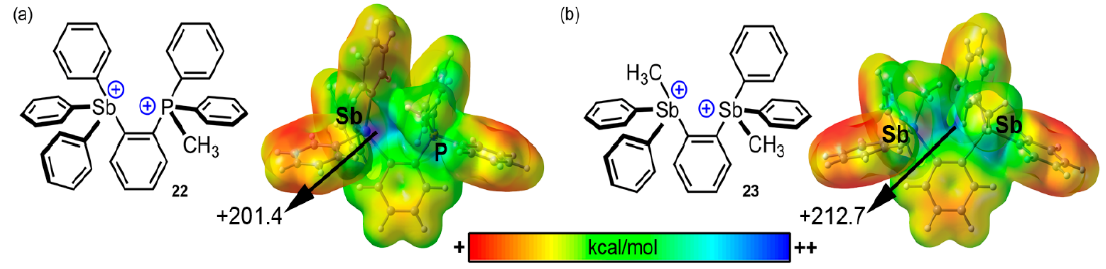
Figure 10. ( a ) Schematic representation of compounds 22 and 23 and ( b ) their corresponding MEP surfaces. Energies at the selected points of the surface are given in kcal/mol (0.035 a.u.).